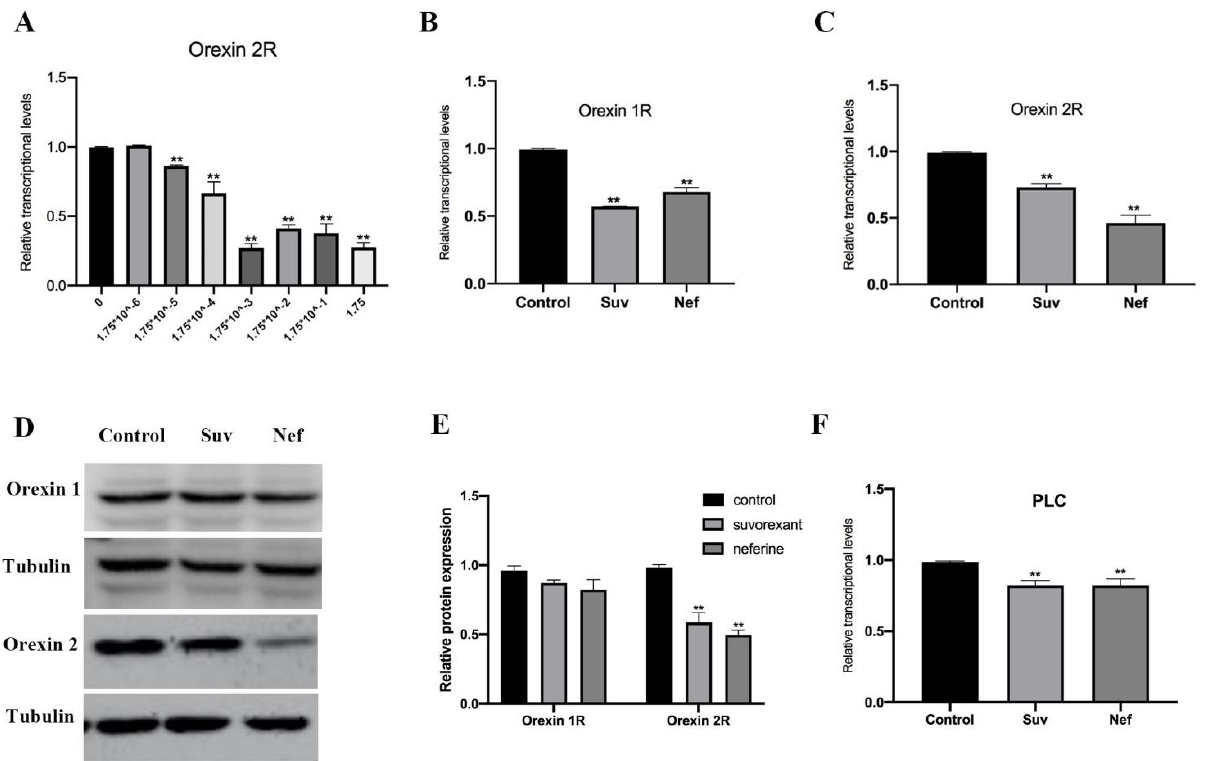
Figure 5. The effect of total alkaloids and neferine on the mRNA expression and protein expression levels of orexin 1, orexin 2, and PLC (( A ): in vitro assay of total alkaloids inhibiting orexin 2 mRNA expression in a dose-dependent manner [ ** p < 0.01 compared with the control group (the CHO cell line is not treated with total alkaloids )]; ( B ): mRNA expression levels of orexin 1 were determined through real-time PCR assay ( ** p < 0.01 compared with the control group); ( C ): mRNA expression levels of orexin 2 were determined through real-time PCR assay ( ** p < 0.01 compared with the control group); ( D ): CHO cells were treated with neferine for 24 h, and protein expression was detected from these cells; ( E ): the levels of orexin 1 and orexin 2 were quantified via Western blotting, with tubulin antibody as a control ( ** p < 0.01 compared with the control group); ( F ): mRNA expression levels of PLC were determined through real-time PCR assay ( ** p < 0.01 compared with the control group).